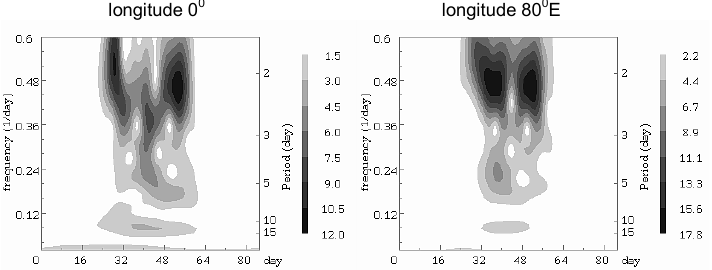
Fig. 8. Periodograms for zonal wave numbers s=1 (upper left panel), s=2 (upper right panel), and s=3 (middle left panel), and for the entire spectrum, including all wave numbers (middle right panel) at 54 ◦ N, 90km height. The results are presented for a 1450-hour run. The arrows point at peaks involved in decoupling of the s=3 wave into waves with s=2 and s=1. In the lower panels running S-transform spectra are shown for 2 different longitudes. Amplitudes (m/s) are shown by grey